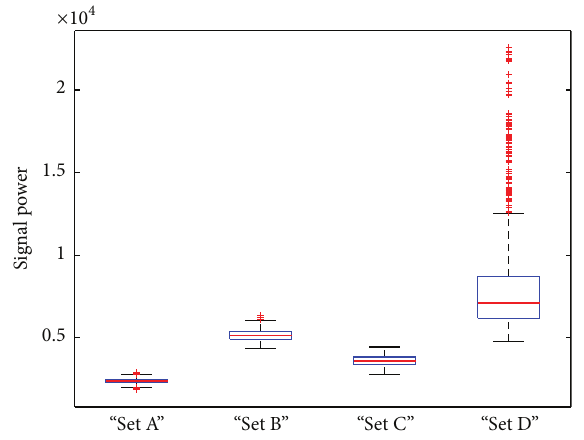
Figure 2: Box plots of average power of signal segments for datasets A, B, C, and D; the length of signal segments 𝑙 = 512 is used.